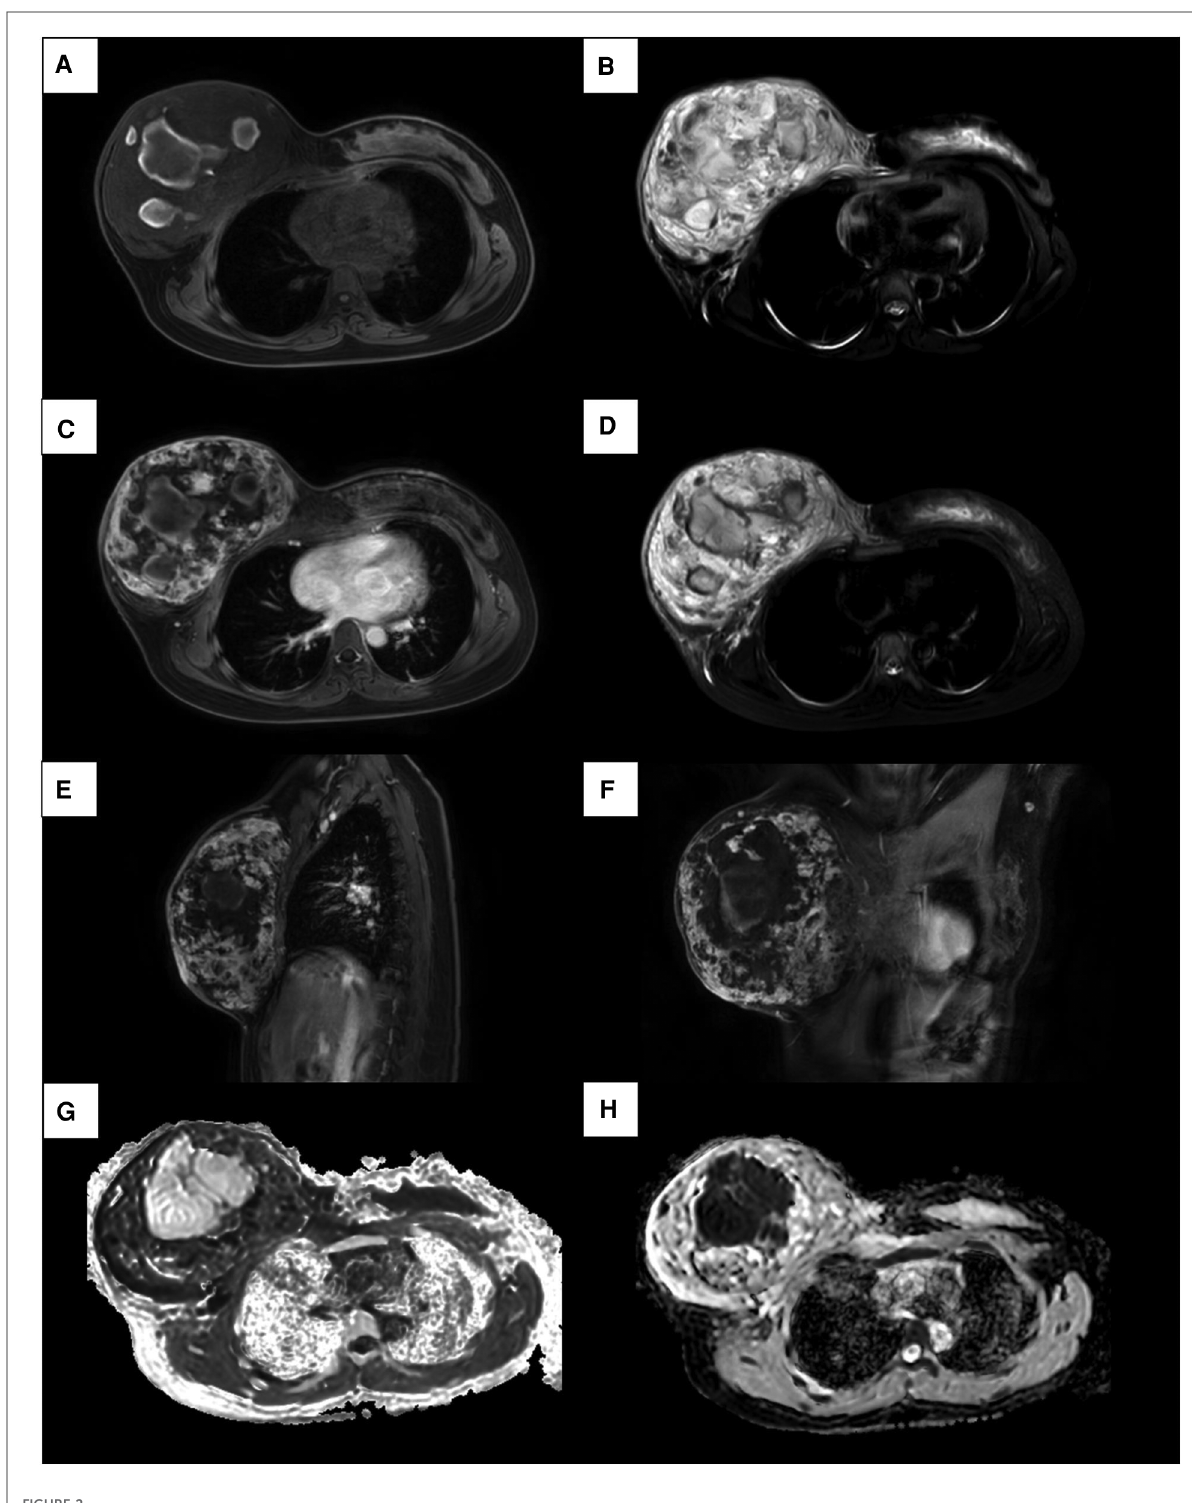
FIGURE 2 MRI images of a 17-year-old female patient with right primary breast angiosarcoma. ( A ) MRI images show a mixed signal intensity area predominantly composed of isointense mass on T1. ( B ) Mixed signal intensity area predominantly of high signal intensity on T2. ( C, E, F ) Enhancement sequences image showed irregular heterogeneous high signal intensity. ( D ) On fat-suppressed T2-weighted images, the lesion shows bright (high) signal intensity. ( G ) High signal intensity on DWI and ( H ) low signal intensity on ADC images demonstrate restricted